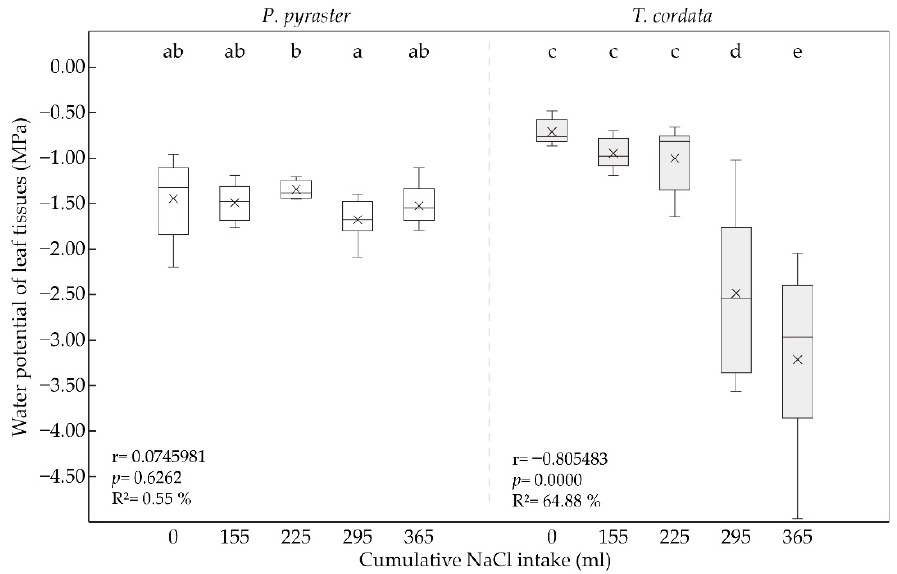
Figure 3. Box plot for the water potential of leaf tissues ( Ψ wl ) of the seedlings of P. pyraster and T. cordata measured at the beginning of the experiment (0 mL) and during the experiment when treated with 100 mM NaCl solution. Significant differences between measurements ( p ˂ 0.05) are indicated by different letters.